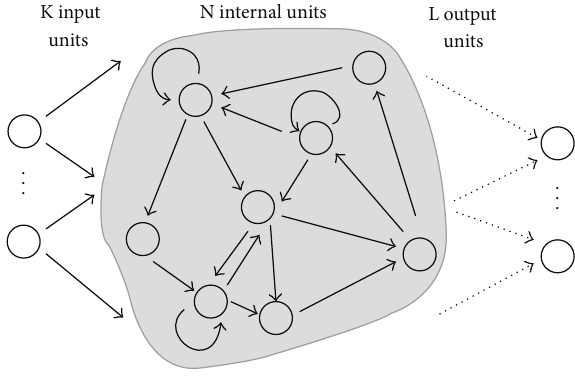
Figure 1: Architecture of standard ESN